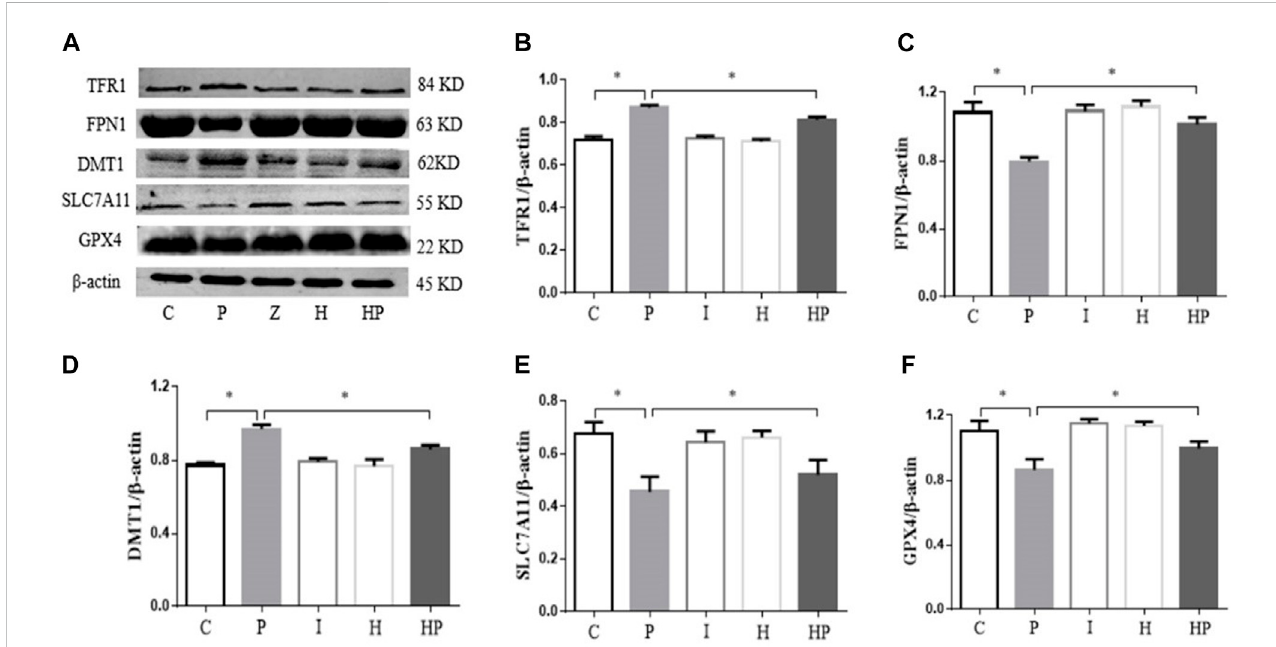
FIGURE 5 Protein expression levels of TFR1, FPN1, DMT1, SLC7A11 and GPX4 in primary hippocampal neurons exposed to propofol with or without hypoxic preconditioning. (A) TFR1,FPN1,DMT1,SLC7A11andGPX4proteinexpressionwasdetectedbyWesternblotanalysis. (B – F) Quantitativeanalysisoftheratioof TFR1, FPN1, DMT1, SLC7A11 and GPX4 to β -actin (one-way ANOVA, * p < 0.05).